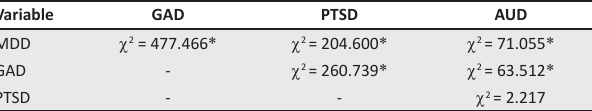
TABLE 8: Diagnosed comorbidities for MDD, GAD, PTSD, and AUD diagnosed comorbidities. Variable